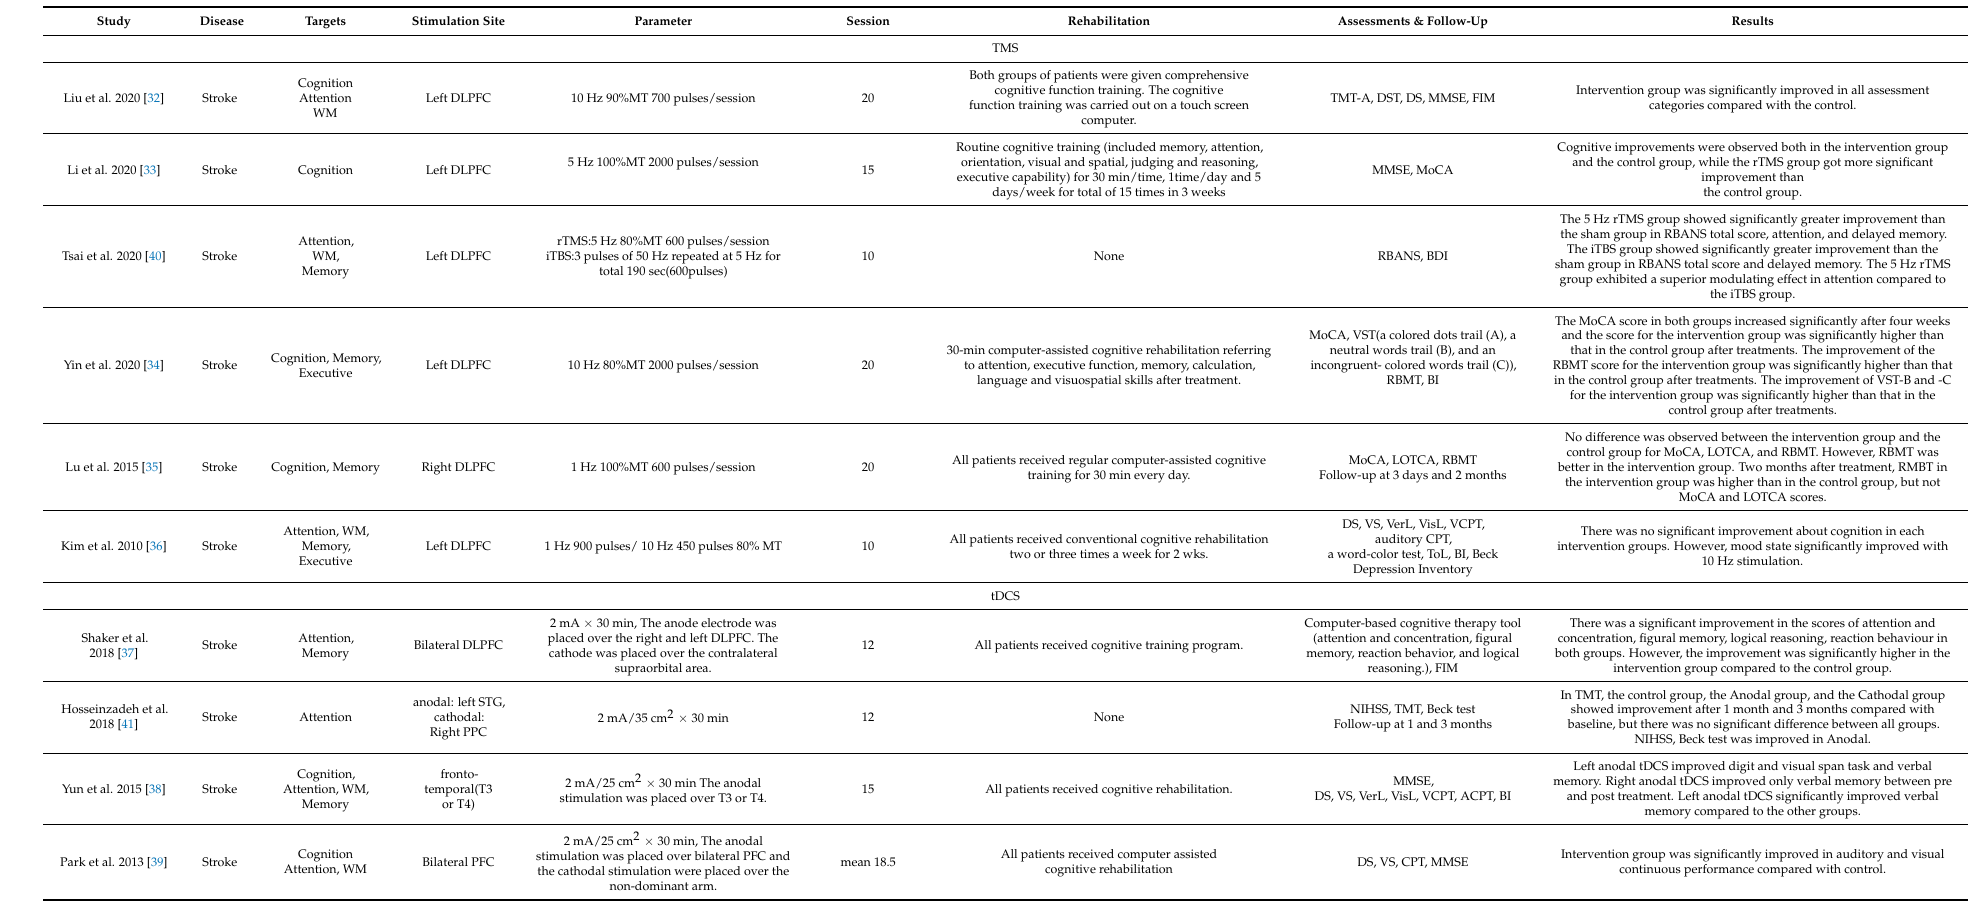
Table 2. Individual Study Treatment Characteristics, Assessments, and